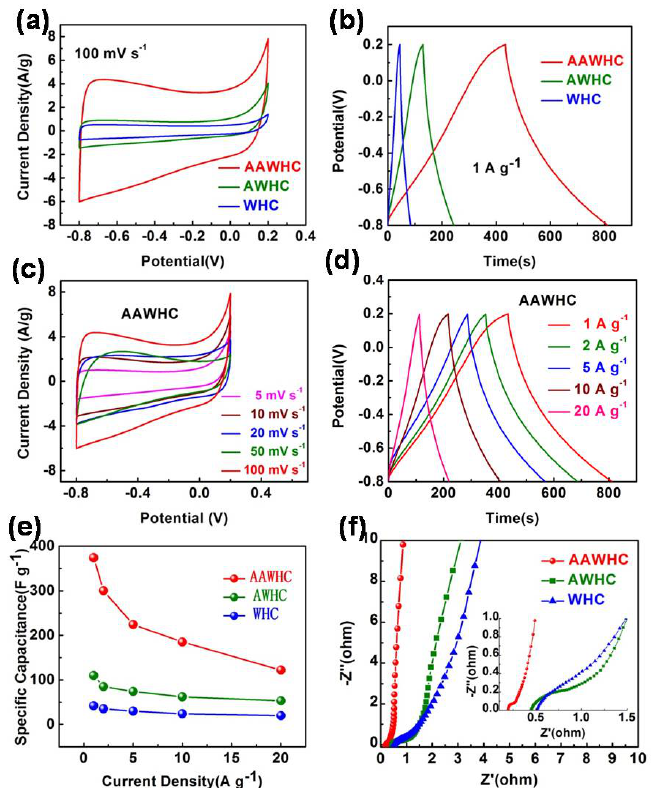
Figure 5. Electrochemical tests in a three-electrode system. ( a ) CV curves of the samples at a scan rate of 100 mV s − 1 . ( b ) GCD curves of the samples at a current density of 1 A g − 1 . ( c , d ) CV and GCD curves of AAWHC at di ff erent scan rates and current densities, respectively. ( e ) Specific capacitance of the samples at di ff erent current densities. ( f ) Nyquist plots of the